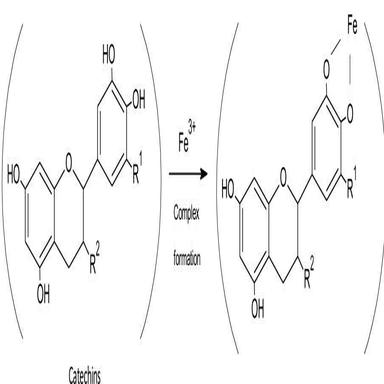
Iron complexes formed by catechins and Fe(III).